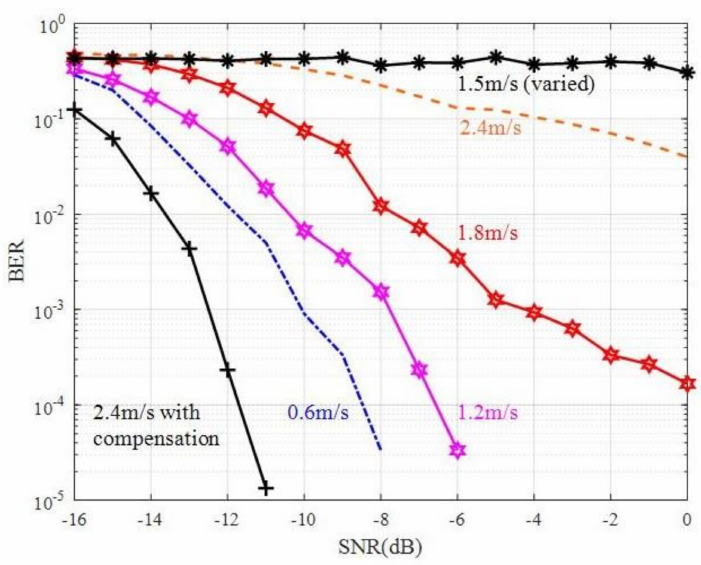
Figure 6. BER curves of the conventional MSS method under different motion